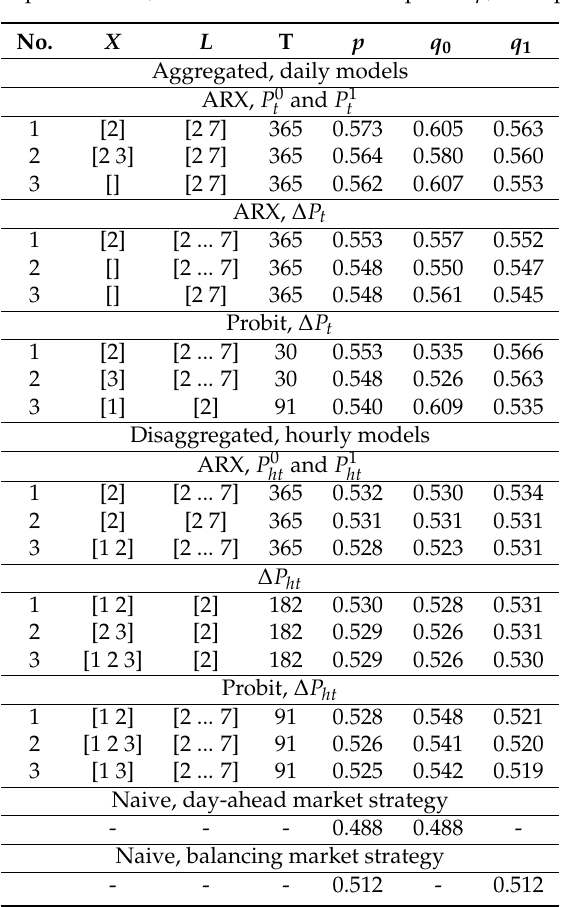
Table 3. A summary of the forecast accuracy for Polish data. Note that the results for only the top three, best-performing model specifications, in terms of classification power p , are reported in each